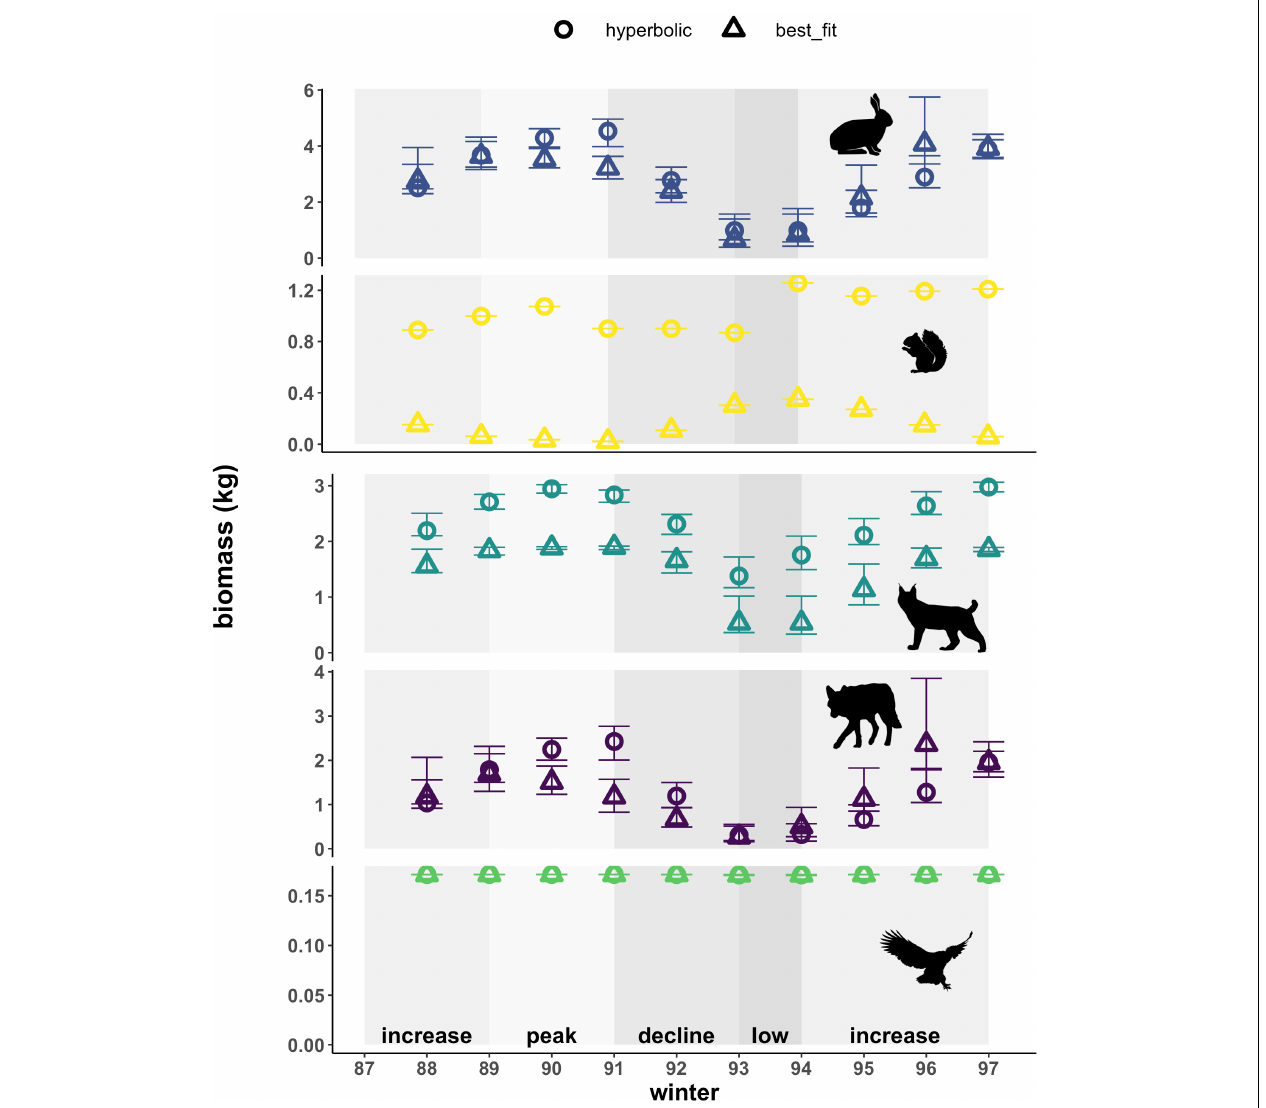
FIGURE 5 | Cumulative biomass of prey killed (hare, red squirrel) by predators (lynx, coyote, owl), based on hyperbolic and best-fit functional response models. Cumulative biomass represents per capita daily kill rates converted to biomass estimates using the mean mass of each prey. Error bars show uncertainty in cumulative biomass killed based on upper and lower limits of 95% confidence intervals for hare density estimates. Shading indicates phases of the cycle as defined by hare density. Also note varying y-axis scale for each